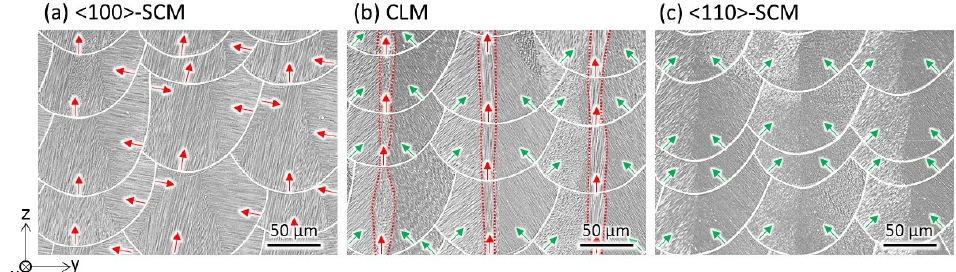
Figure 7. SEM images displaying the melt pool shapes and the direction of cell growth.